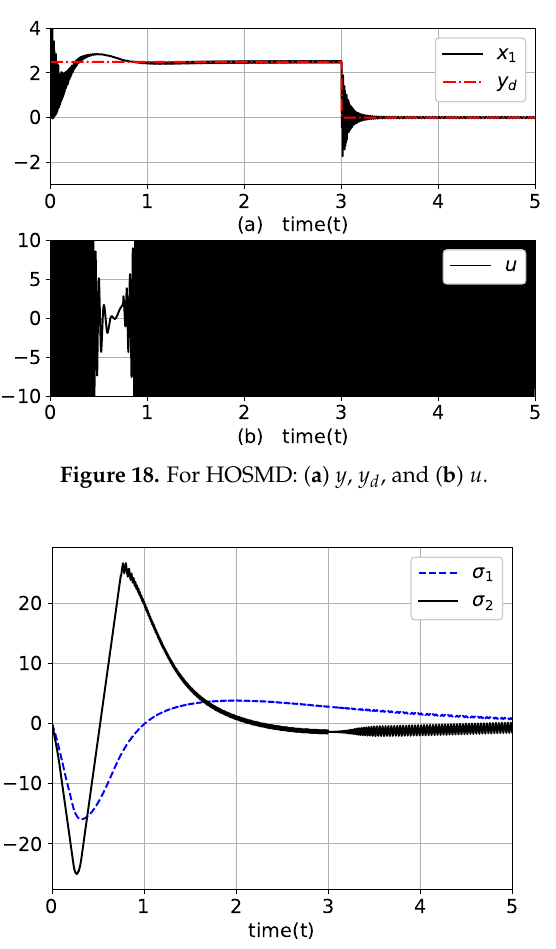
Figure 19. For HOSMD: trajectories of σ 1 and σ 2 .